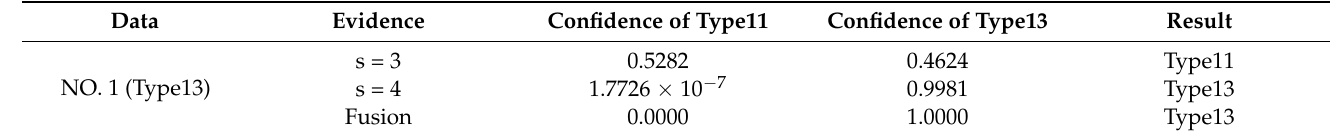
Table 4. Fusion results of misclassified data in scale s = 3.